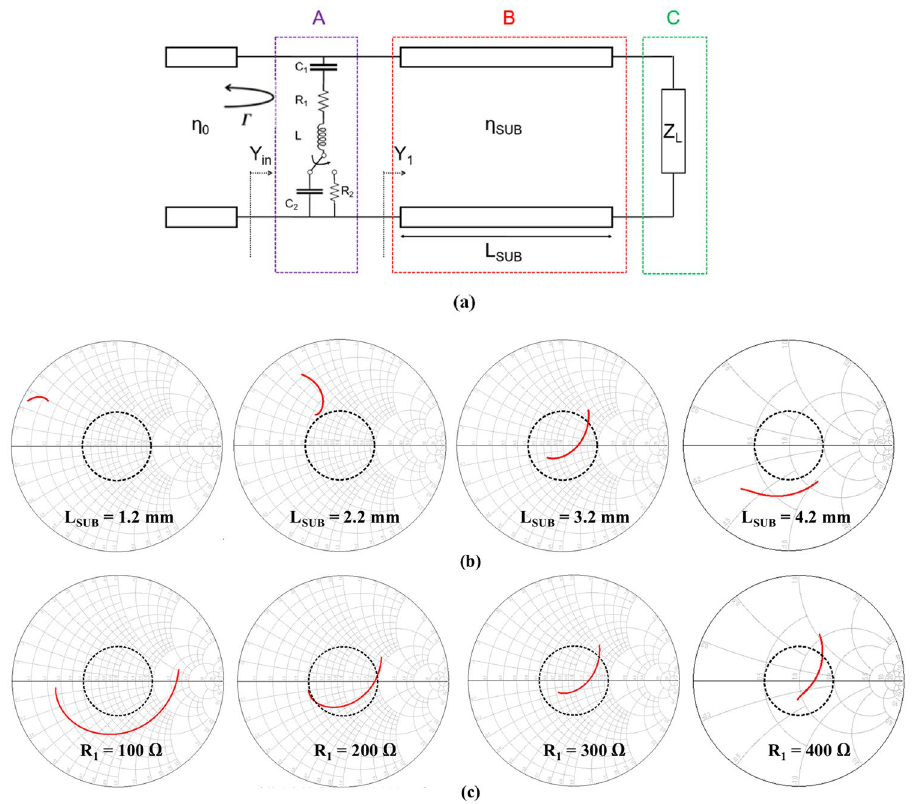
Figure 3. ( a ) Transmission line mode. ( b ) Input impedance traces from 8 to 12 GHz on Smith chart at different ( b ) L SUB and ( c ) R 1 . The dotted line is 2:1 VSWR